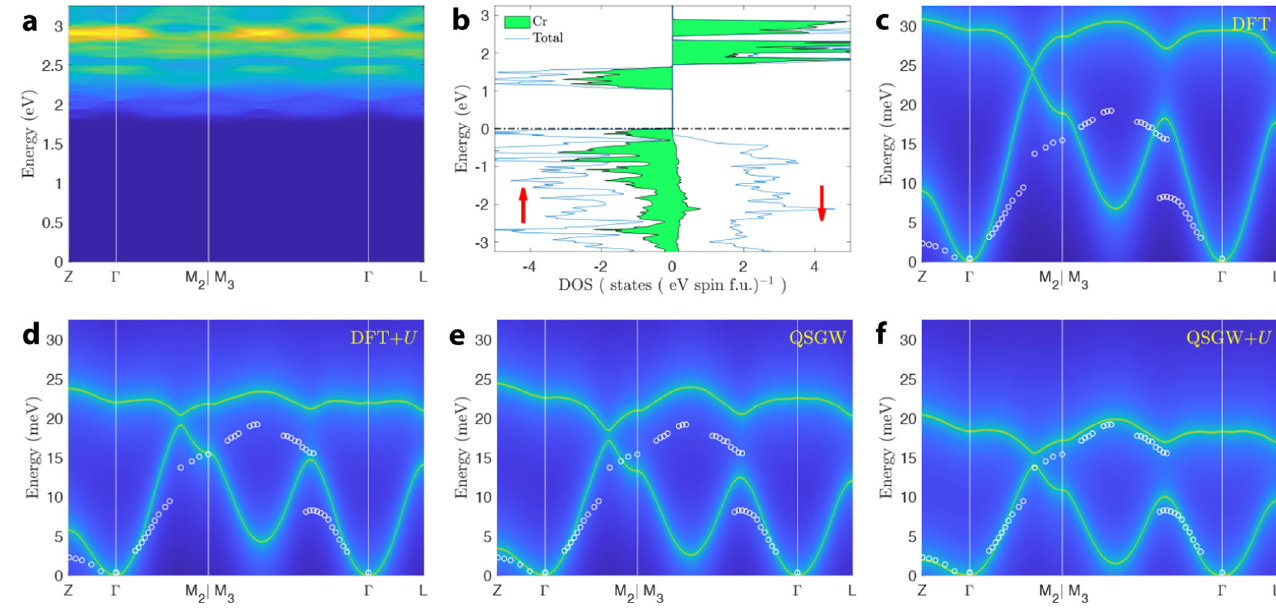
Fig. 2 Spin excitations calculated from Im ½ χ q ; ω ð Þ(cid:2) and Im ½ χ q ; ω ð Þ(cid:2) in R-CrI 3 . The special q points along the high-symmetry path Z – Γ – M 2 ∣ M 3 – 0 Γ – L are denoted in Fig. 1c, d. a Im ½ χ q ; ω ð Þ(cid:2) calculated in DFT. b The density of states calculated in DFT. The horizontal dashed-and-dotted line 0 indicates the top of valence band. c – f Im ½ χ q ; ω ð Þ(cid:2) calculated in DFT ( c ), DFT + U ( d ), QSGW ( e ), and QSGW + U ( f ). The intensity of Im ½ χ q ; ω ð Þ(cid:2) is shown in log scale. Experimental SW energies, adopted from INS work by Chen et al. 16,28 , are denoted by open circles.